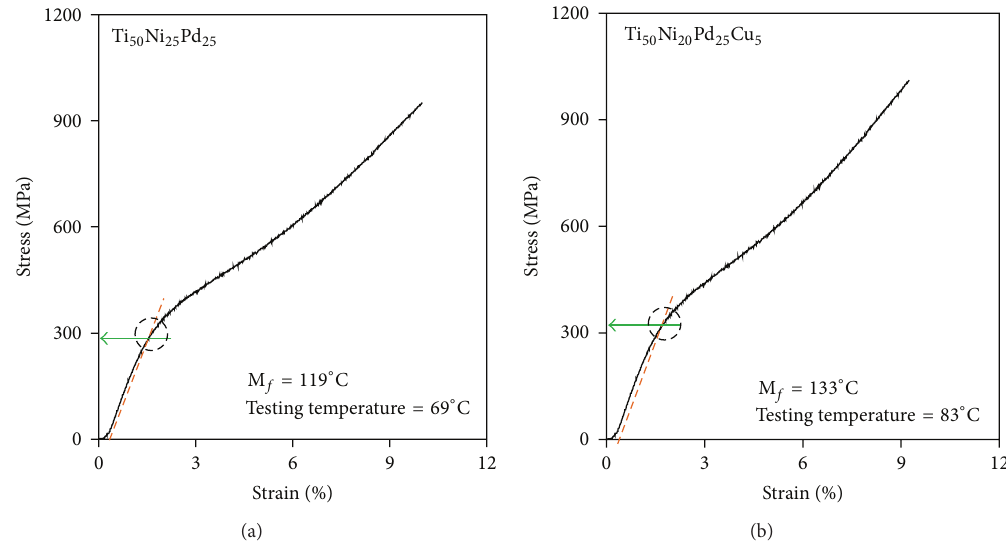
Figure 2: Tensile stress-strain curves tested in the martensite condition, 50 ∘ C below M 𝑓 of (a) Ti 50 Ni 25 Pd 25 and (b) Ti 50 Ni 20 Pd 25 Cu 5 alloys.